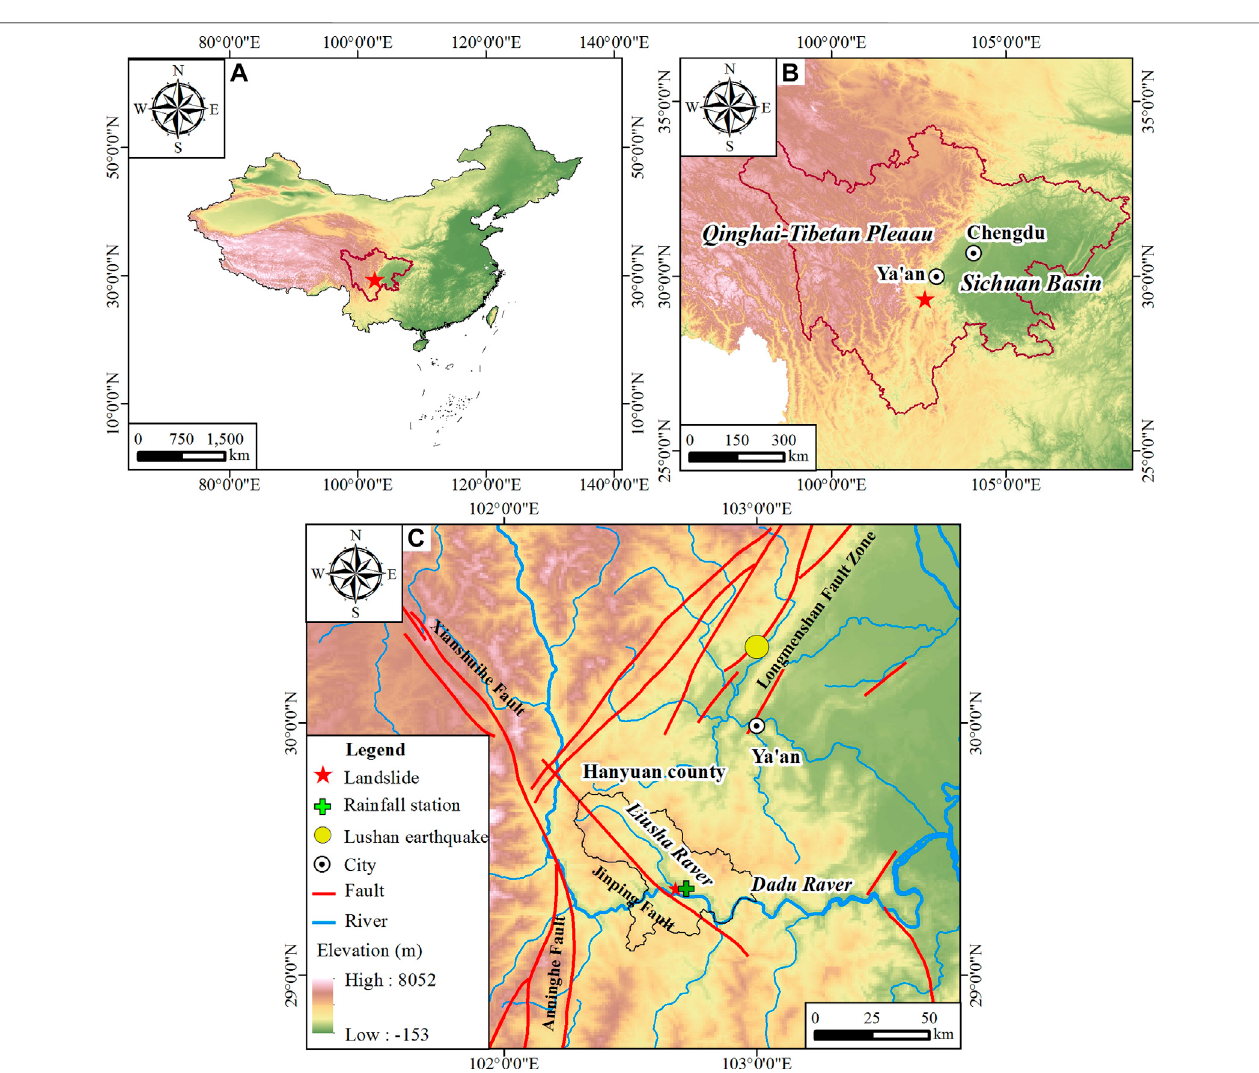
FIGURE 1 | The location of the Zhonghai landslide in (A) China, (B) Sichuan Province. (C) The distribution of the faults and the river systems.